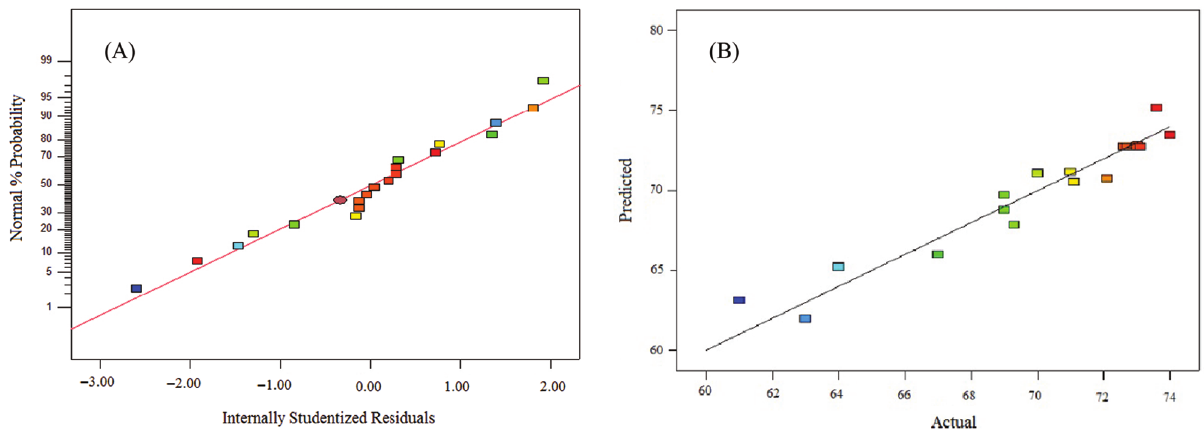
Figure 3: Normal % probability plots (A) and Predicted values versus experimental values for WR